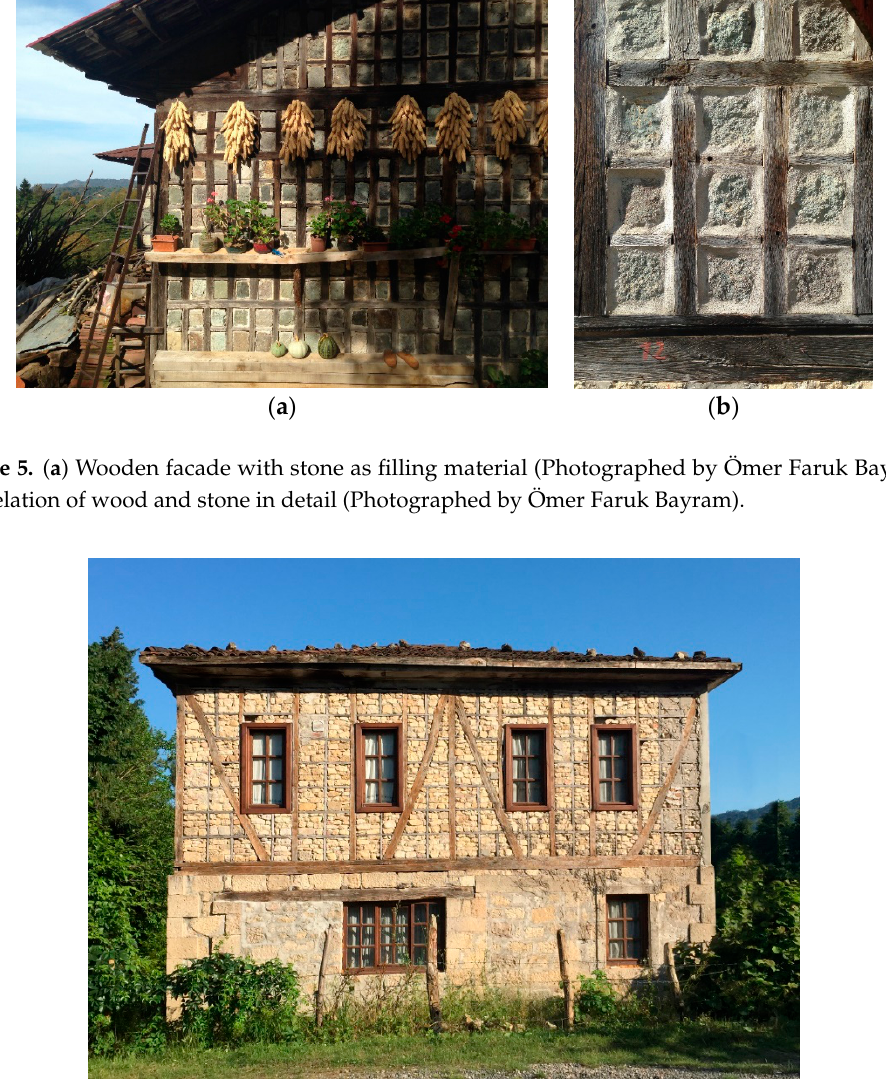
Figure 6. Vernacular house facade made of stone and wood obtained locally (Photographed by Ömer Faruk Bayram).